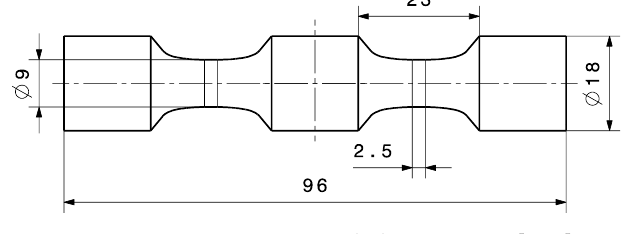
Figure 3. HCF specimen B with dimensions in [mm].